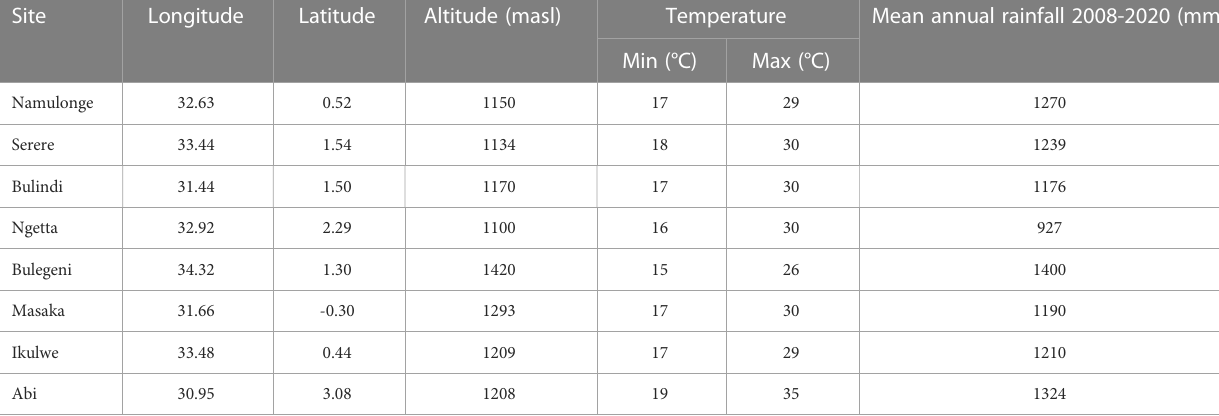
TABLE 1 Agro-metreological characteristics of the trial sites in Uganda.